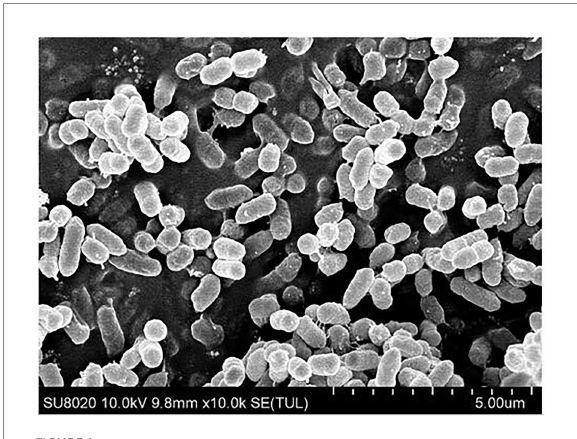
FIGURE 1 The cell morphology of strain CD3 under scanning electron